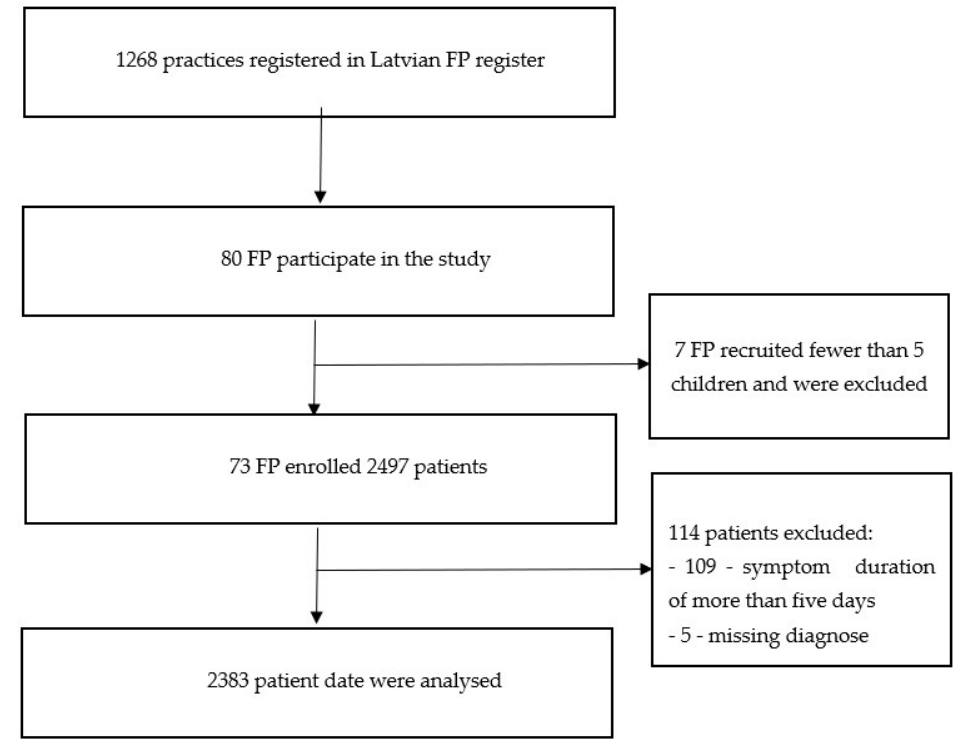
Figure 1. Flowchart of included family physicians (FP) and recruited illness episodes.